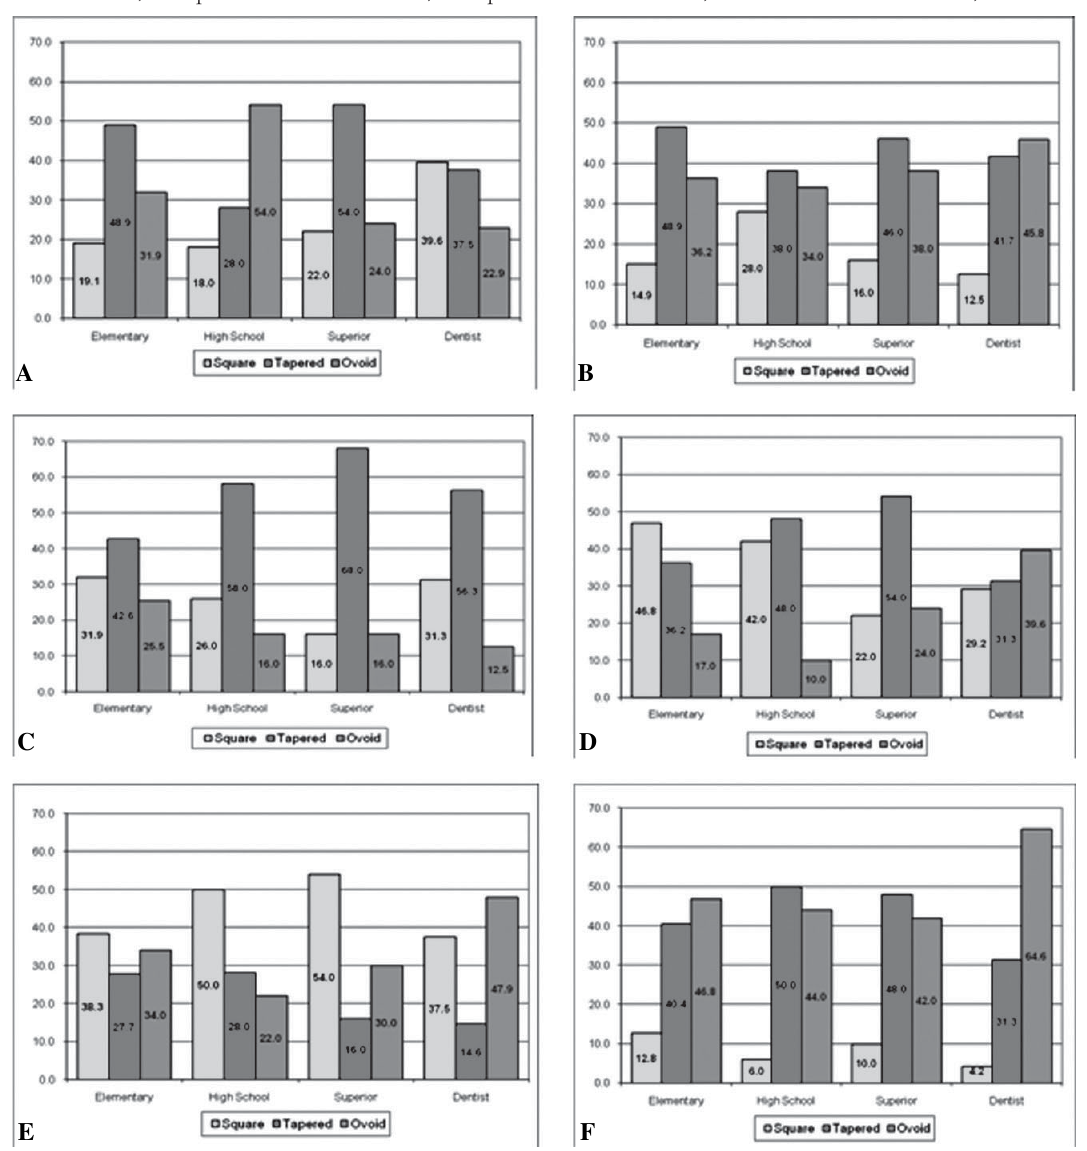
Fig. 6 - Male ovoid facial contour set. Each photograph presents a different shape of upper central incisors. Results Groups were not statistically different by their gender distribution (p=0.080), but were statistically different by age (p<0.001). The group with elementary education was the oldest group (46.60 + 11.5 years), Table 1 - Aesthetic perception towards different combination of facial contours and upper incisors tooth shape: A – square female facial contour; B – square male facial contour; C – tapered female facial contour; D – tapered male facial contour; E – ovoid female facial contour; F – ovoid